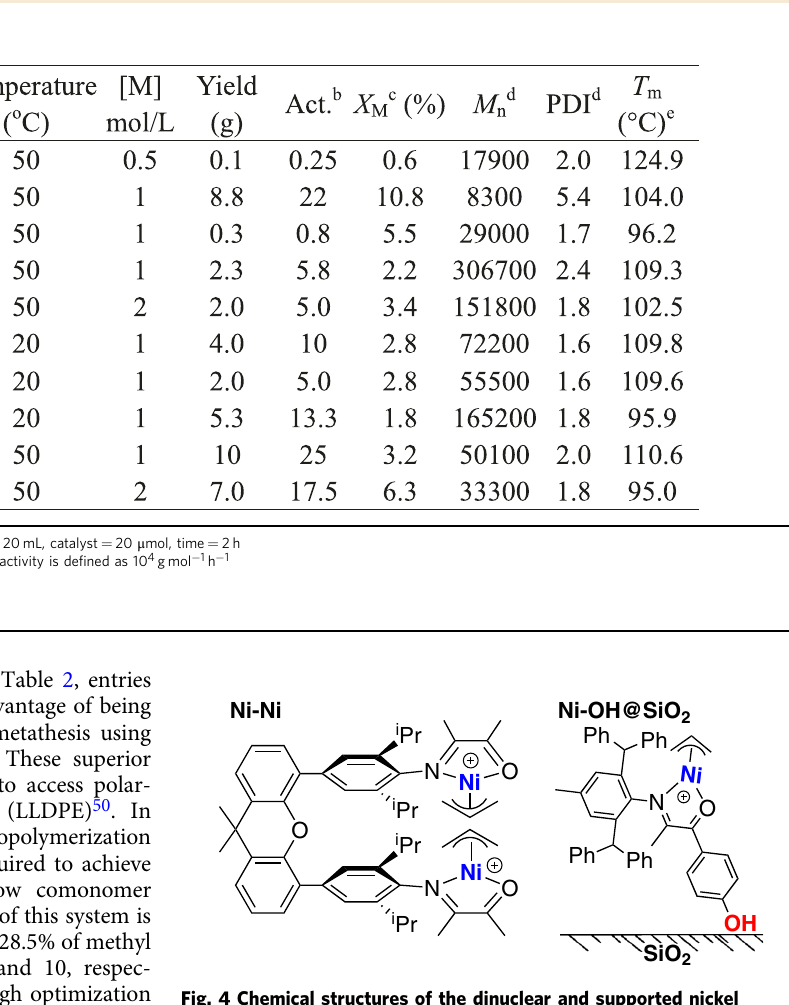
Table 2 Ethylene copolymerizations with polar monomers with Ni complexes.